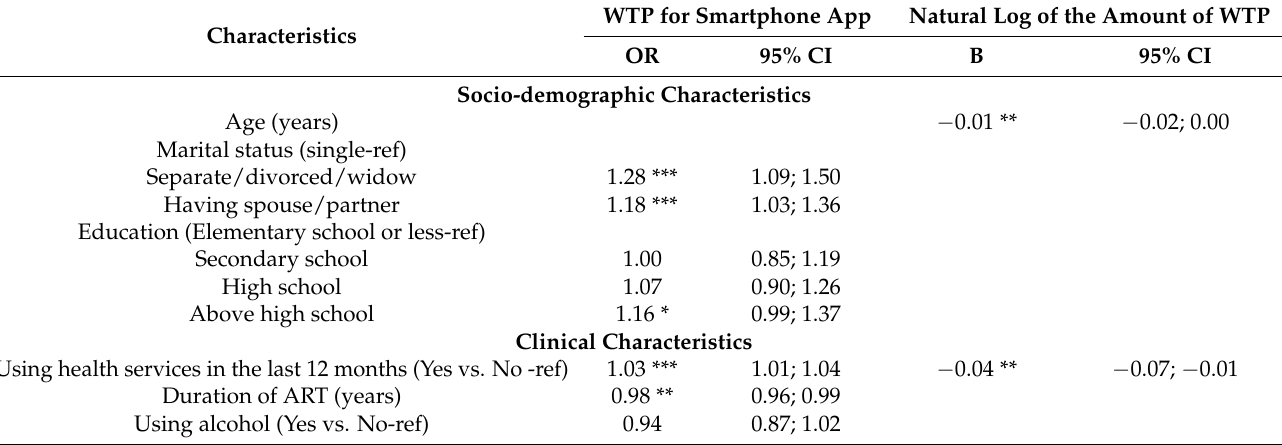
Table 4. Associated factors with WTP and the amount of WTP.